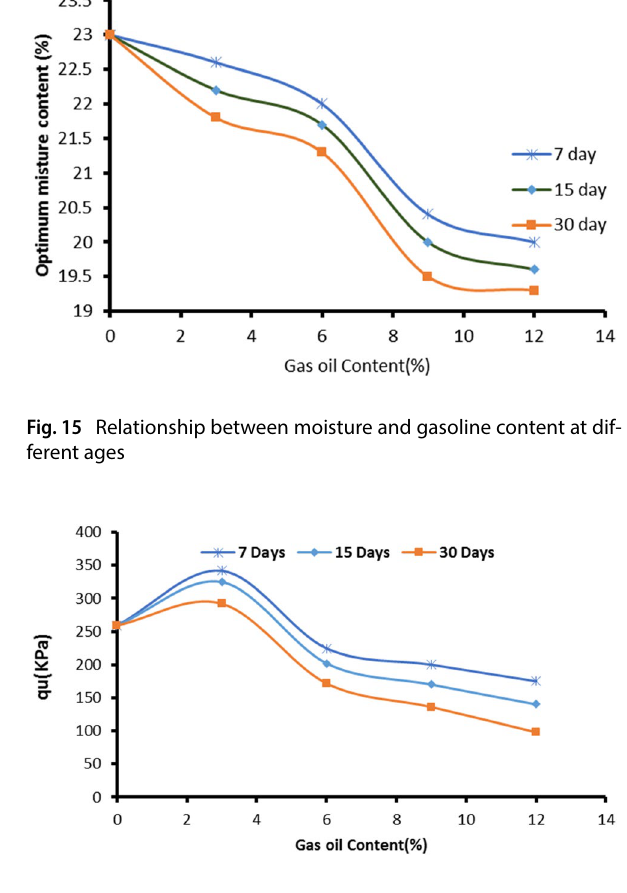
Fig. 16 Unconfined compressive strength variations at different gasoline contents and different ages